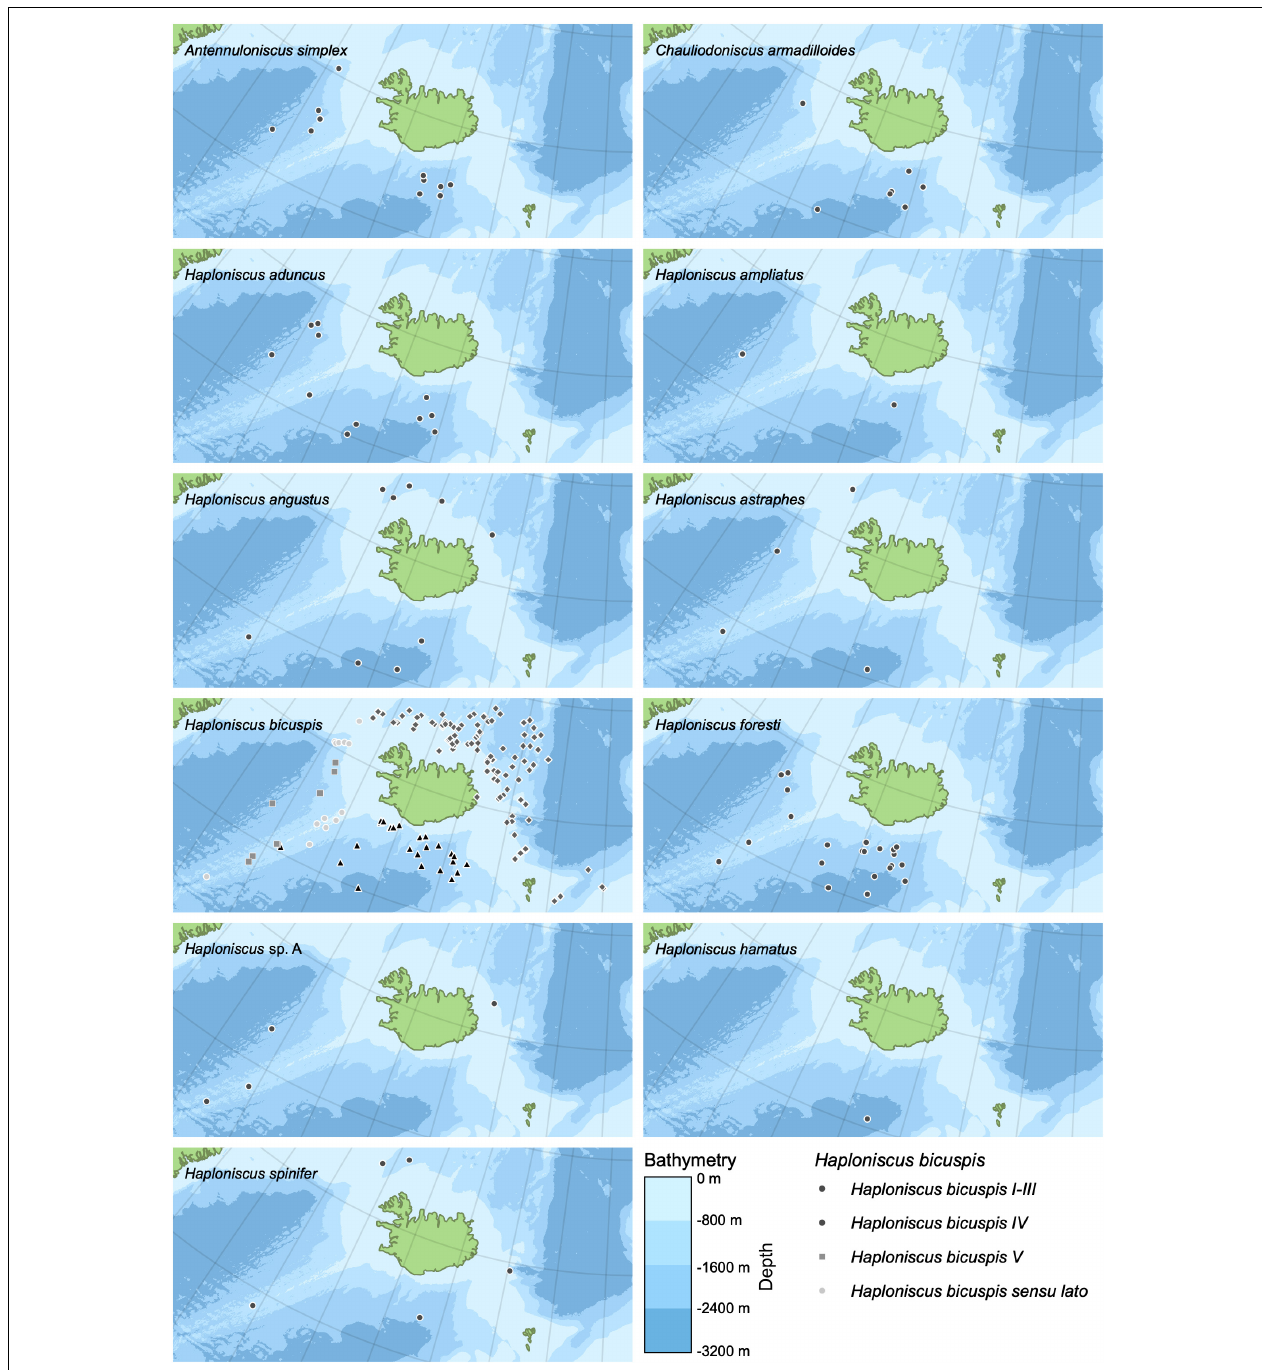
FIGURE 9 | Distribution maps of individual Haploniscidae species found around Iceland (Source for bathymetry: GEBCO Bathymetric Compilation Group, 2020).